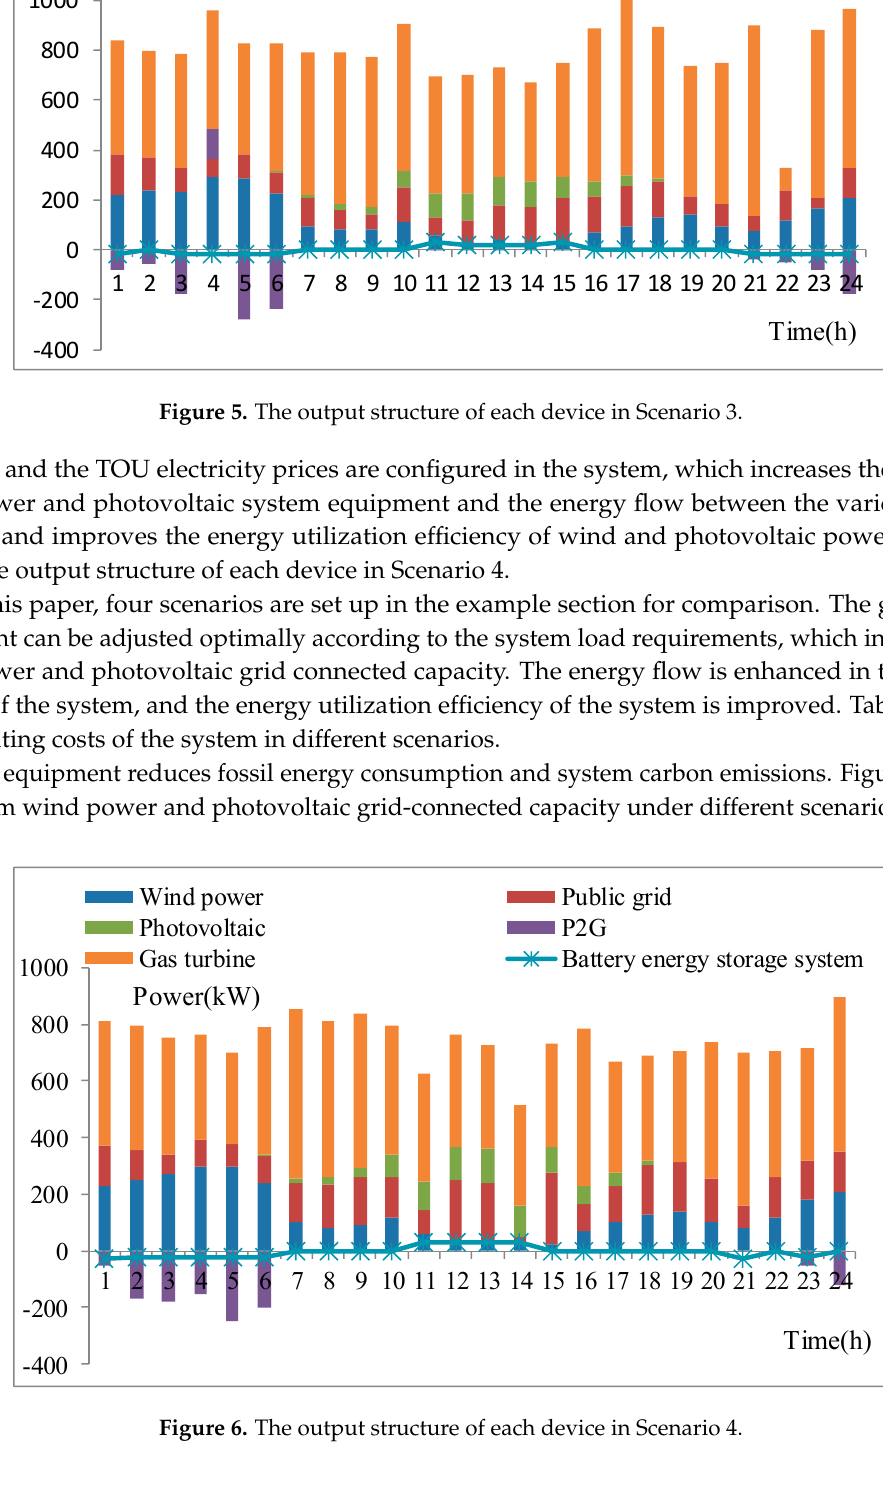
Figure 4. The output structure of each device in Scenario 2.